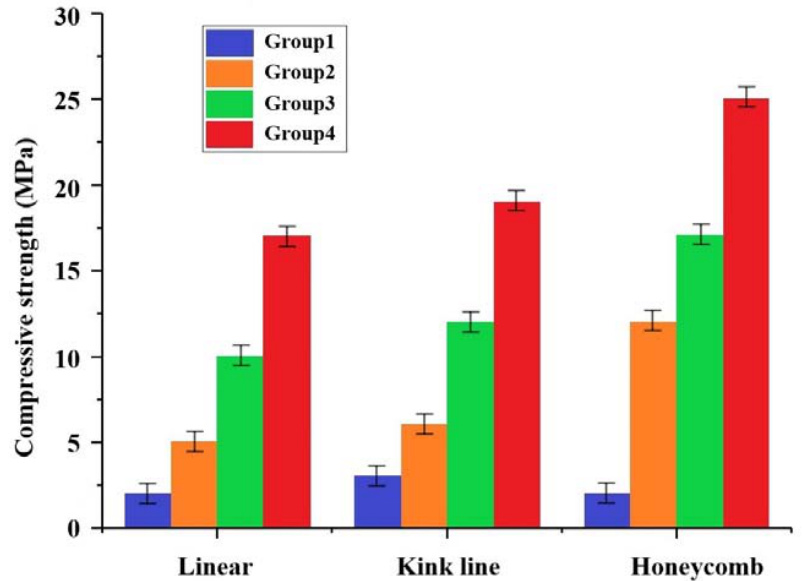
Figure 11. Compressive strength of the artificial bone scaffold in all pore structures.